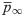
Long-term value p¯∞ of the fraction of cooperators versus the cost-to-benefit ratio ρ in the sculling game on empirical networks.(a) Γhepth. (b) Γastro. (c) Γfb. (d) Γinternet. The dashed lines show the critical values of the cost-to-benefit ratio ρc=1k-1+1.